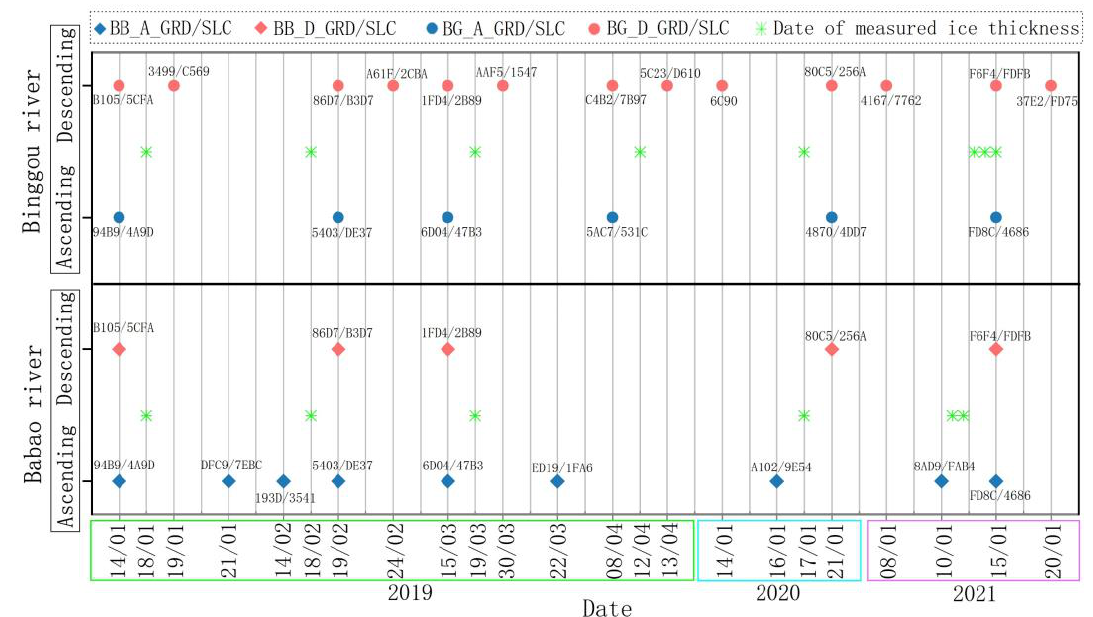
Figure 3. Dates on which Sentinel-1 measured the river ice thickness during 2019–2021. The Babao River data are represented by diamonds, and the Binggou River data are represented by circles; blue indicates ascending, and orange indicates descending (for example, B105/5CFA indicates the acquired GRD/SLC data).